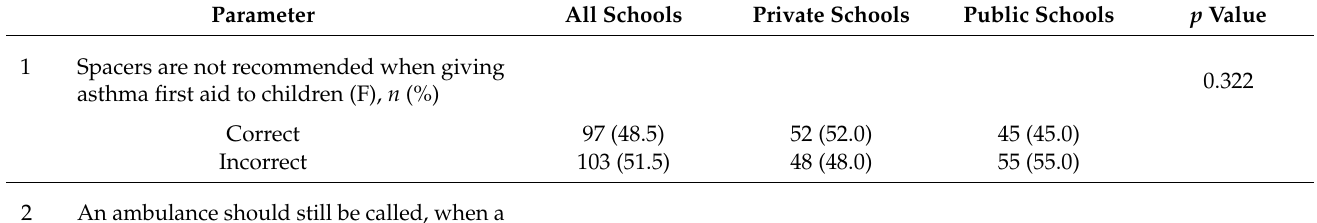
Table 3. Asthma first-aid knowledge in